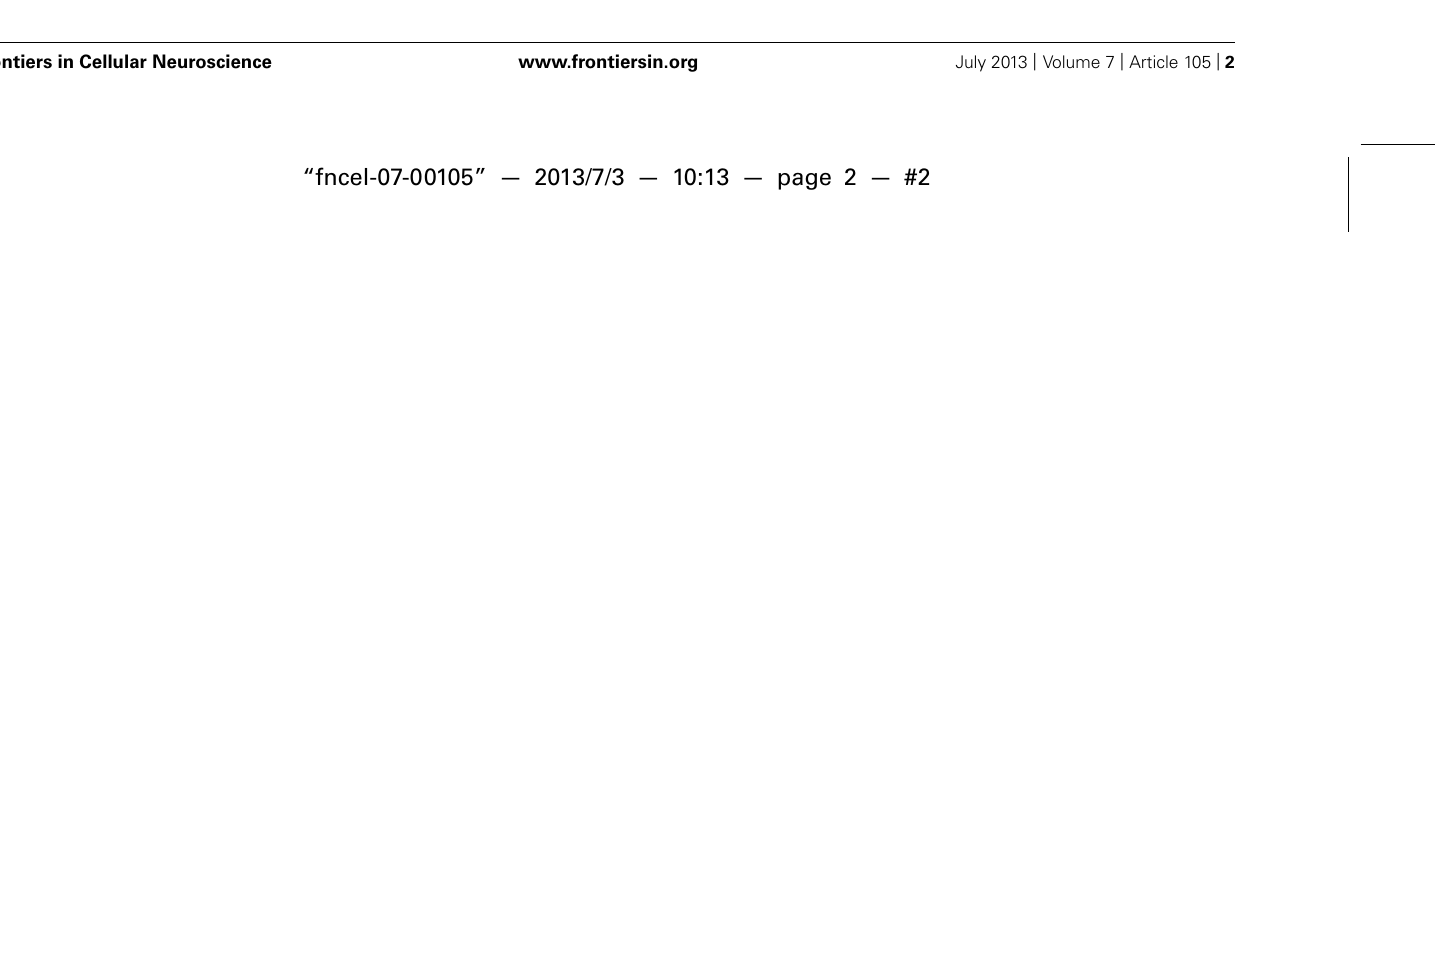
FIGURE 1 |The visual system of the Drosophila larva. (A) Complete overview of Drosophila larva showing the localization of the larval eye and projection to the central brain. CE, cephalopharyngeal skeleton. (B) Schematic representation showing the larval eye and projection to both hemispheres of the central brain. (C) Confocal scanning of the Bolwig organ (BO) and Bolwig nerve (BN, in green) targeting the larval optic neuropile